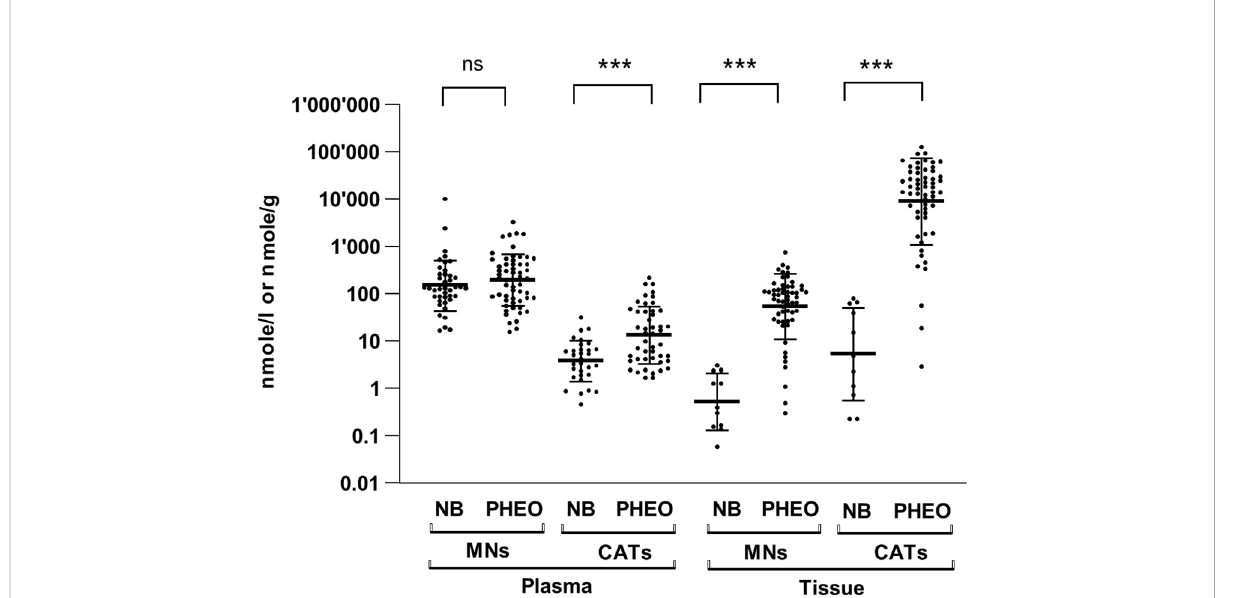
FIGURE 1 Plasma and tissue concentrations of CATs and MNs in NB and PHEO. Sum of CATs/MNs values and geo mean ± geo SD are plotted on a logarithmic scale and analyzed with a non-parametric Mann-Whitney test (non signi fi cant= ns, ***= p <0.001, ****= p <0.0001). Values are reported in the text. Number of patients for plasma values: MNs: NB (n=41), PHEO/PGL (n=57); CATs: NB (n=31), PHEO/PGL (n=47); and for tissue values: MNs: NB (n=11), PHEO/PGL (n=57); CATs: NB (n=11), PHEO/PGL (n=57). MNs concentrations represent total forms (free and SO 4 - conjugated forms) in plasma and free forms in tumors (no conjugated forms are detected in tumor). CATs values represent free forms in both plasma and tumors. Part of these values for NB (n=22/41 for plasma MNs, n= 21/31 for plasma CATs and n=10/11 for tissue values for CATs and MNs) were already published in another study comparing CATs values in human and mice with NB (17) (Supplementary Table